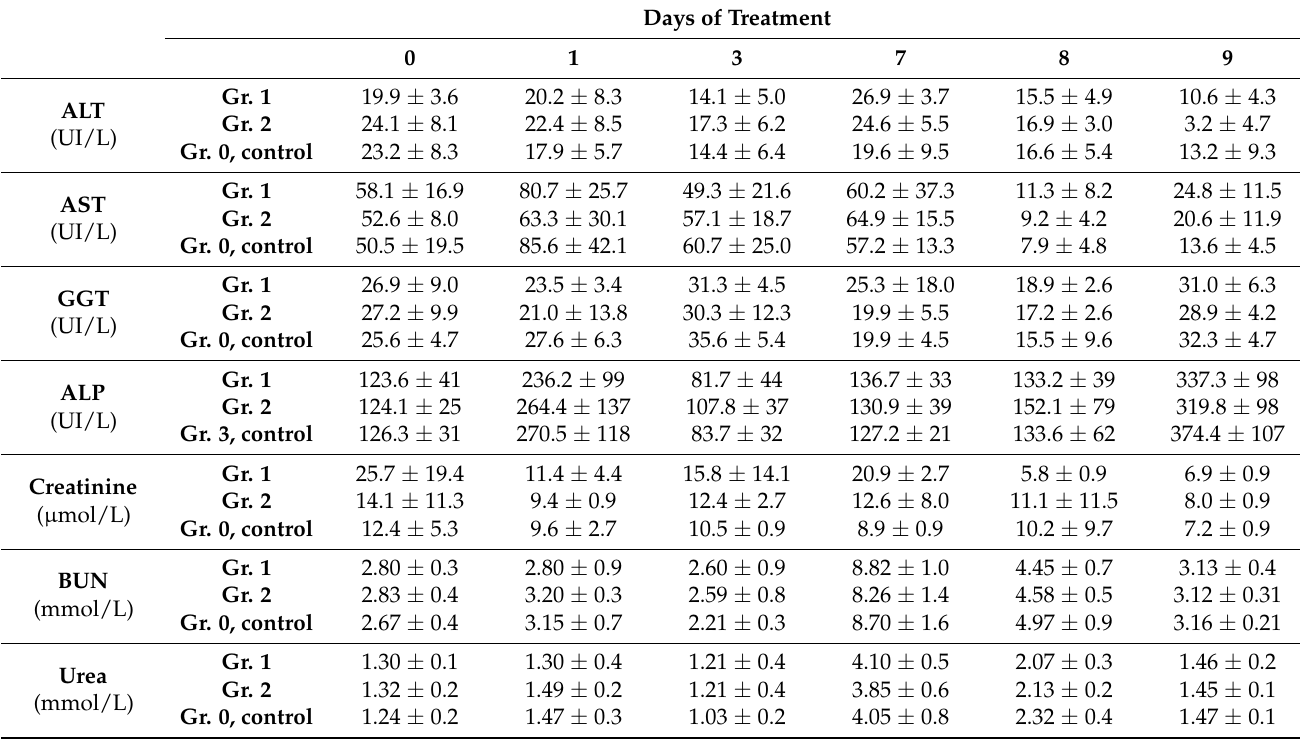
Table 4. Blood parameters (means ± SD) of Pelibuey lambs treated with different doses of Hura crepitans